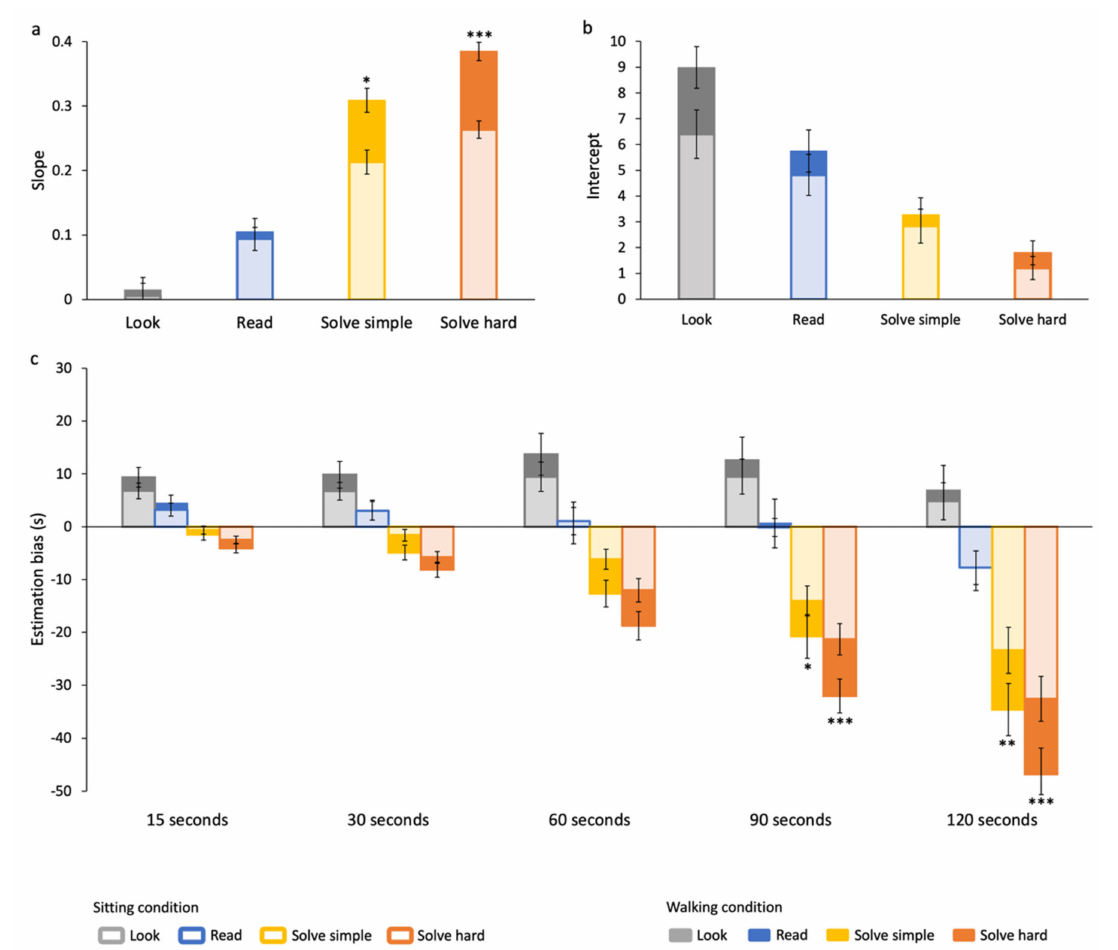
Figure 6. Comparison of time estimation during walking and while sitting for all tasks. ( a ) Slopes of best-fit lines, shown in Figure 3c,d. Asterisks mark statistically significant differences with z-tests: * p < 0.05, *** p < 0.001. ( b ) Y-axis intercepts of best-fit lines, shown in Figure 3c,d. ( c ) Estimation bias averaged over time intervals and participants. Asterisks mark statistically significant pairwise post hoc comparisons: * p < 0.05, ** p < 0.01, *** p <